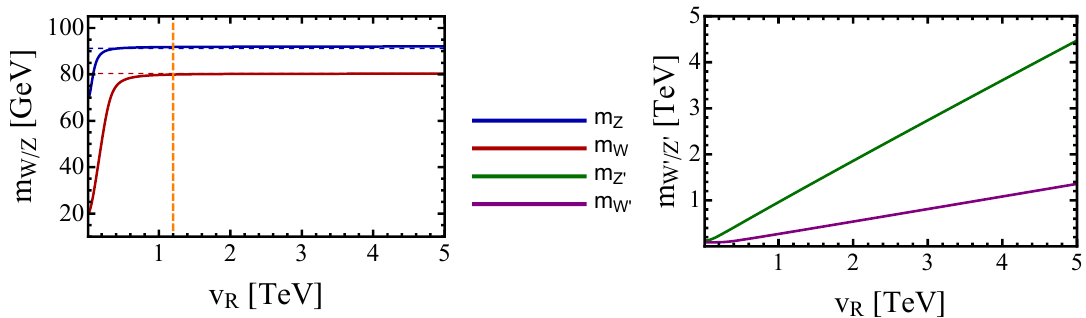
Figure 1 . Plot of the masses of the SM-like gauge bosons m Z and m W (left) and the heavy gauge bosons m and m as a function of the SU(2) breaking scale v . Here the masses were Z 0 W 0 (right) R R found by numerically solving eqs. (2.22) and (2.23) with gauge couplings given by eq. (2.26) assuming the normal running of the SM gauge couplings at these energy scales described in appendix D. We roughly find that v 1 . 2 TeV is required for eq. (2.24) to be valid and to ensure the light gauge R > fields remain SM-like as indicated by the dashed vertical line, the dashed horizontal lines correspond to the measured masses of the electroweak gauge fields. We find that the Z 0 gauge field will be significantly heavier than the W 0 field and a ratio of m 3 . 5 . This is due to the additional Z 0 /m W 0 ’ mixing effects occurring between the neutral gauge bosons compared to the charged